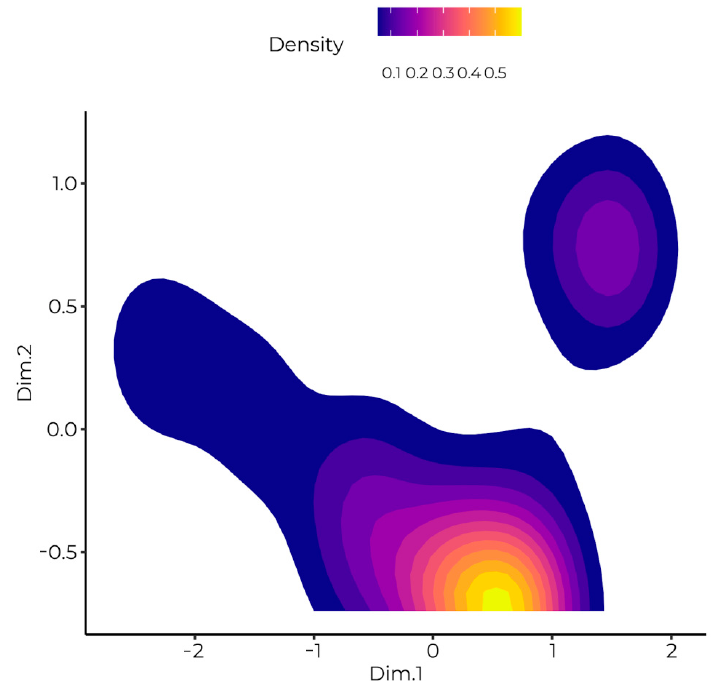
Figure 3. Two-dimensional density estimation for two principal components of face and nose covering. The highest density was observed near the axis crossing, and two extreme subgroups were detected.